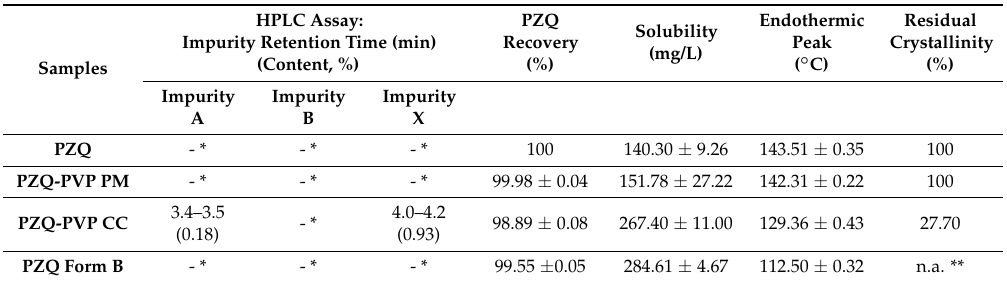
Table 1. Characteristics of the mechanochemically activated materials, in comparison to the raw Praziquantel (PZQ) and PZQ:PVP physical